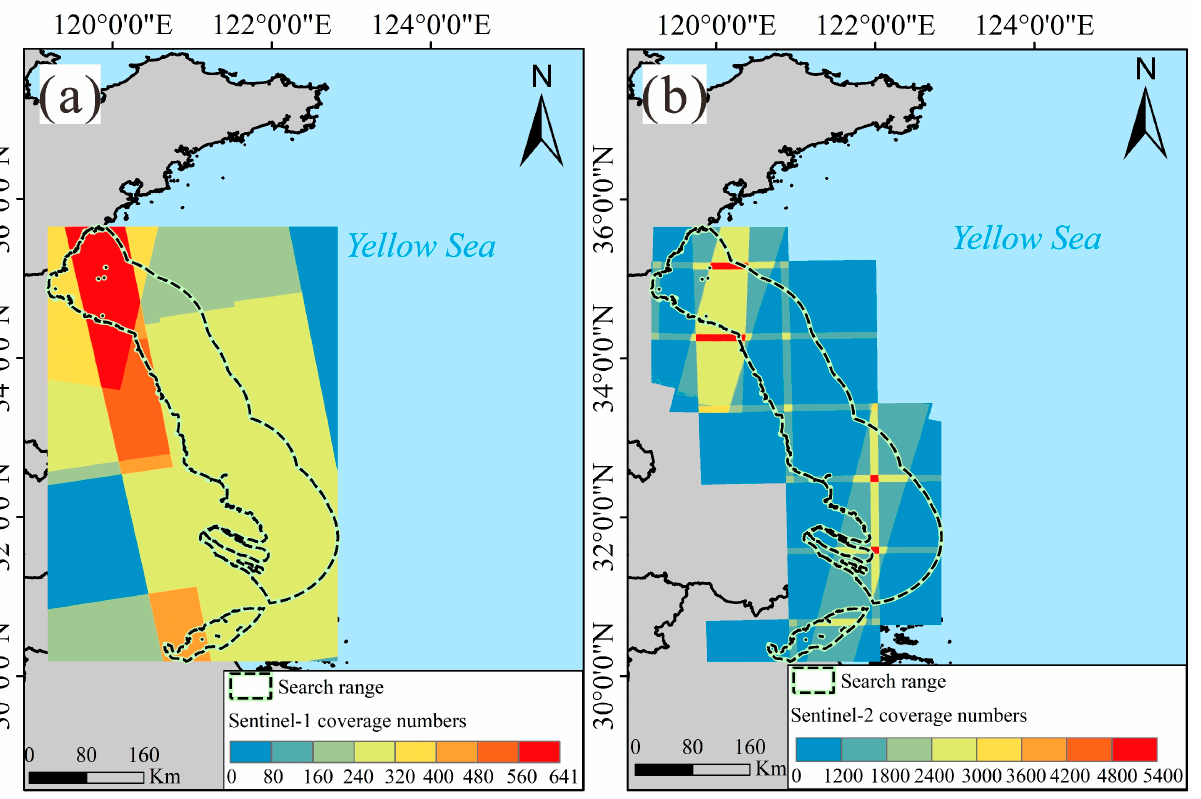
Figure 2. Spatial distribution of Sentinel-1/2 data: ( a ) total number of Sentinel-1 SAR images; ( b ) total number of Sentinel-2 optical images.